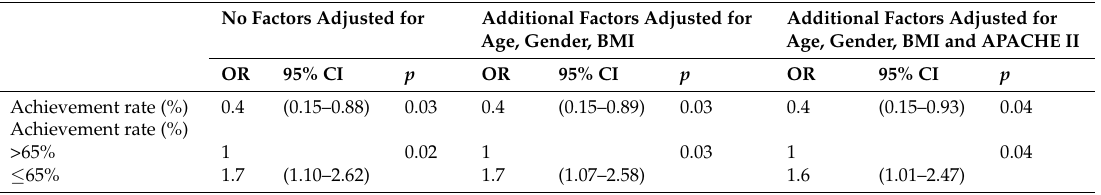
Table 3. Adjusted odds ratios of